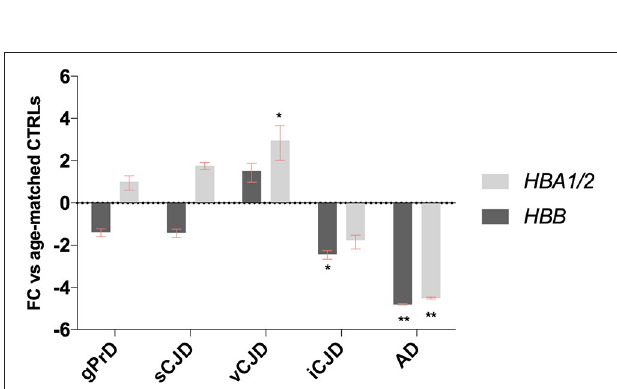
FIGURE 6 | Blood-normalized HBB and HBA1/2 expression. Relative expression levels of HBB and HBA1/2 against GAPDH and against ALAS2 in gPrD, sCJD, vCJD, iCJD, and AD patients. * p < 0.05, ** p <